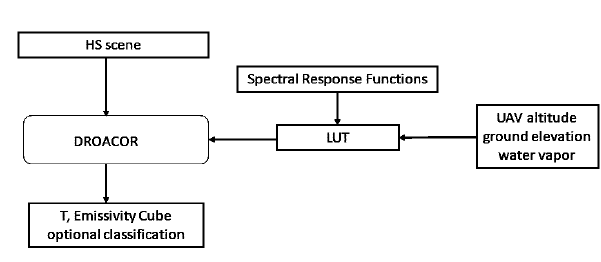
Figure 4. DROACOR flow